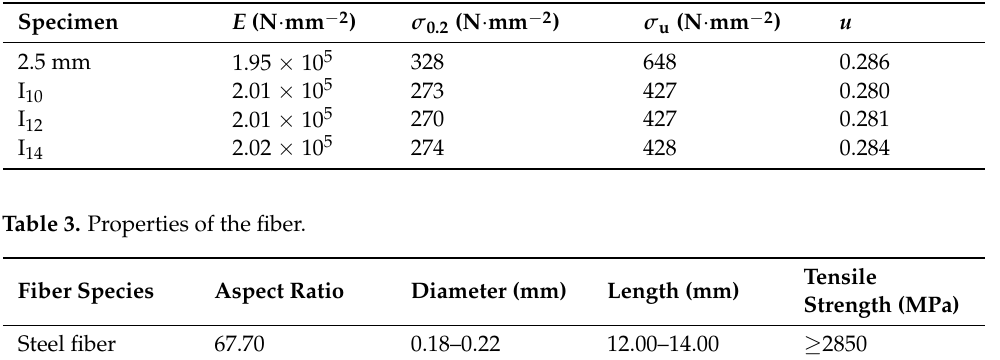
Table 2. Mechanical properties of steel.